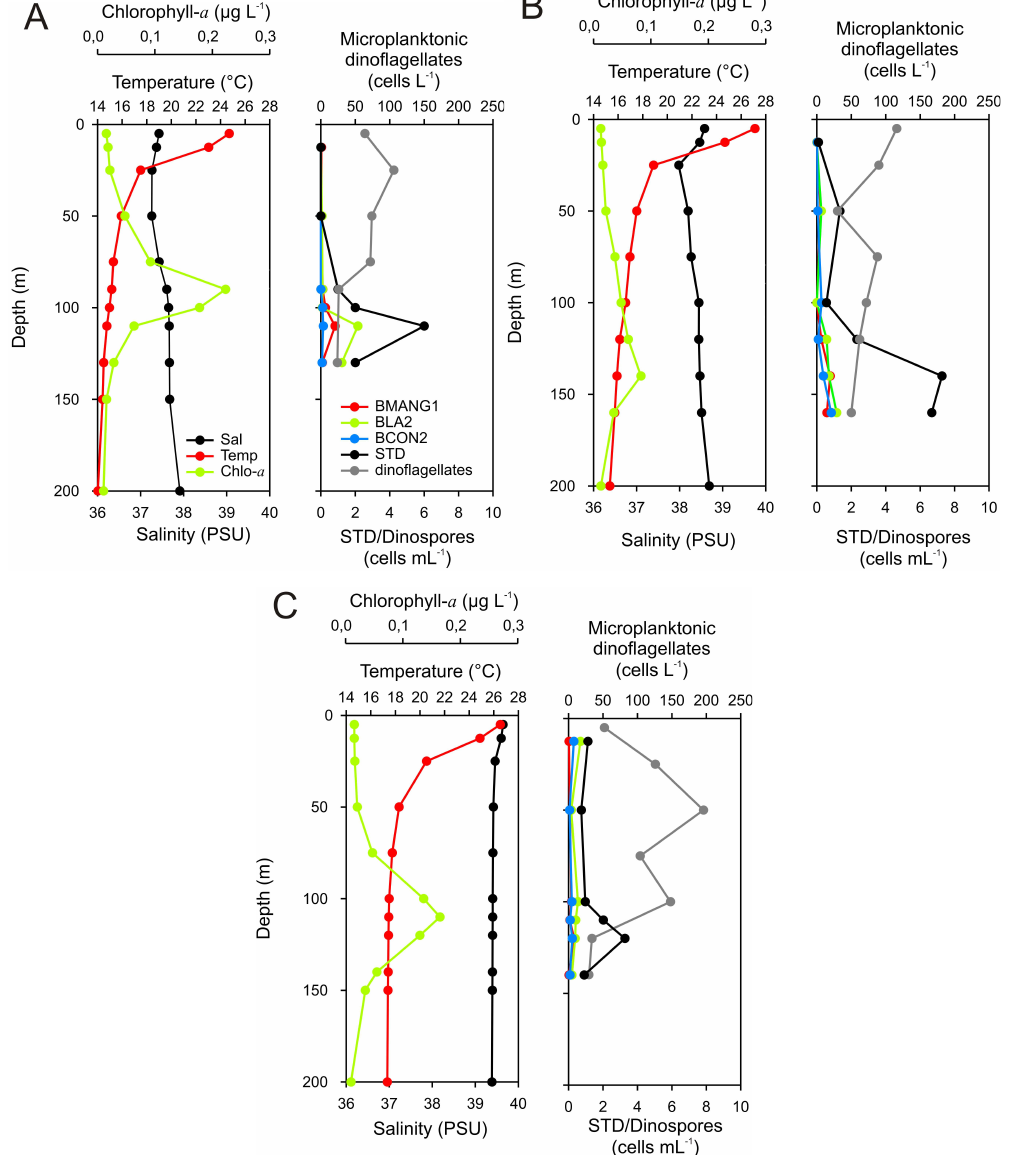
Fig. 6. Vertical distribution of abiotic and biotic parameters at sampling stations A, B, and C. Panels at left: total chlorophyll- a (µgl − 1 ), Temperature ( ◦ C), and Salinity (PSU). Panels at right: total abundances of microplanktonic dinoflagellates (cellsl − 1 ) , Small thecate dinoflag- ellates (STD, cellsml − 1 ) , and Blastodinium dinospores detected by fluorescent in situ hybridization using corresponding probes (BMANG1, BLA2, and BCON2, cells ml − 1 )